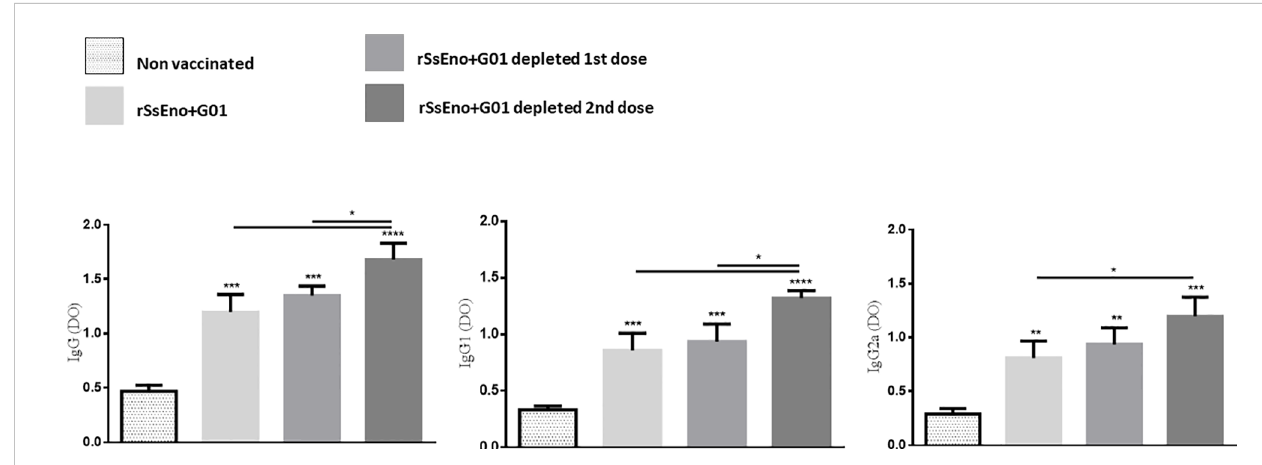
FIGURE 3 Tregs depletion during anti rSsEno booster vaccination promotes enhanced production of serum IgG, IgG1 and IgG2a speci fi c antibodies. *(p < 0.05); **(p < 0.01); ***(p < 0.001); ****(p < 0.0001).